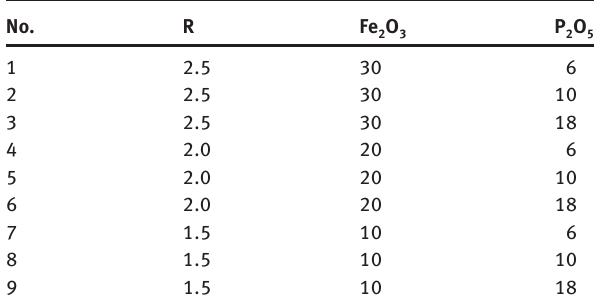
Table 1: Composition of the slag (mass%)